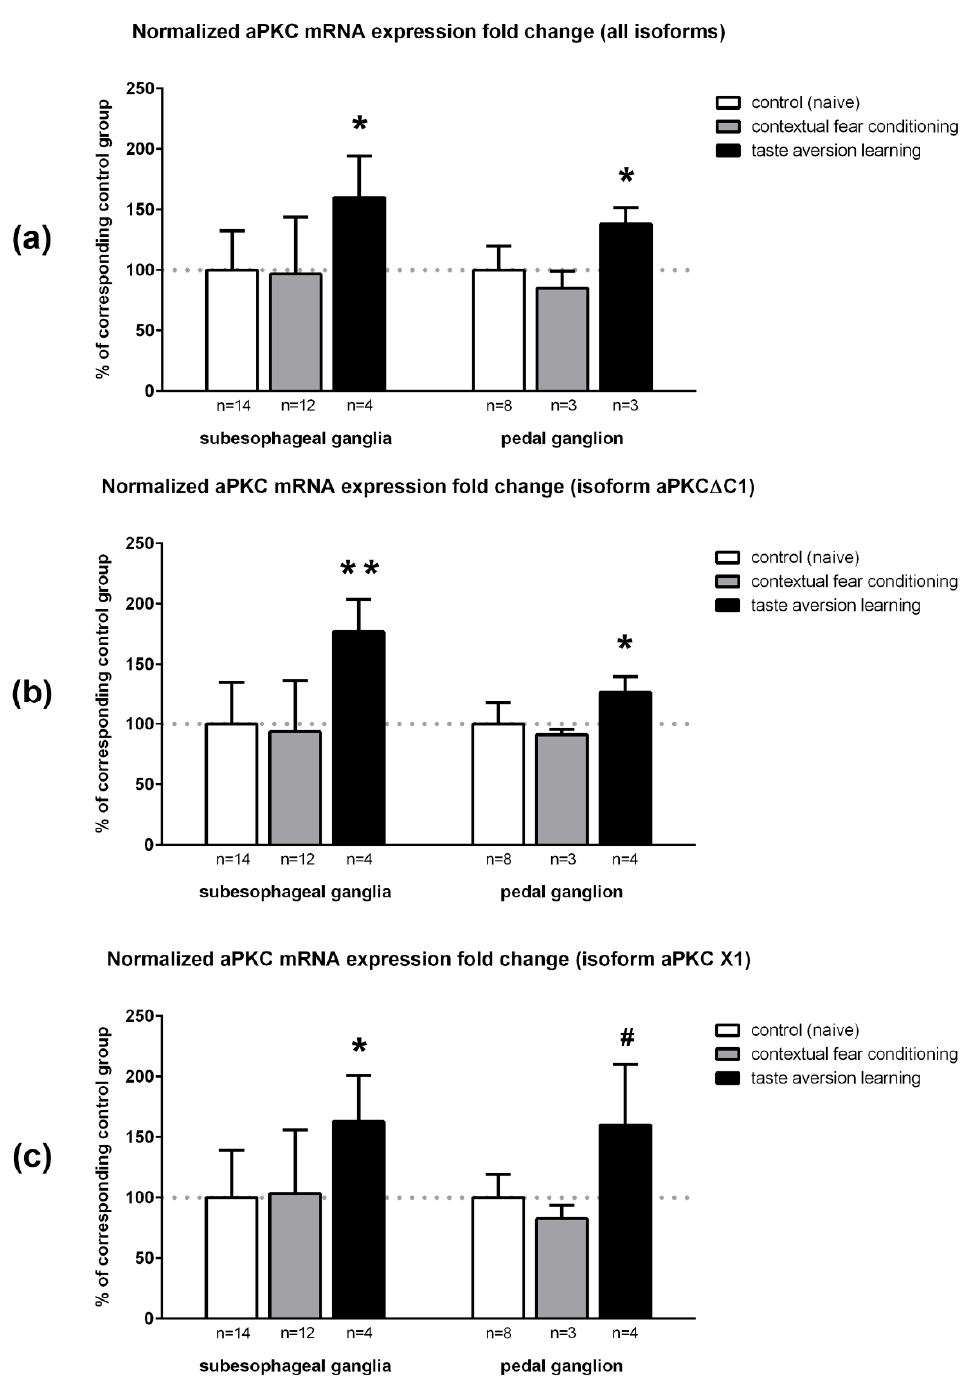
Figure 6. Normalized mRNA expression fold changes of total aPKC and two its isoforms in subesophageal and pedal ganglia of naive (control) snails and in two test groups of trained snails: ( a ) total aPKC; ( b ) aPKC ∆ C1 isoform; and ( c ) aPKC X1 isoform. Data are present as normalized AM ± SD. Horizontal dotted lines mark 100% level. * p < 0.05, ** p < 0.005, # p = 0.073 (Mann–Whitney test) compared to control.